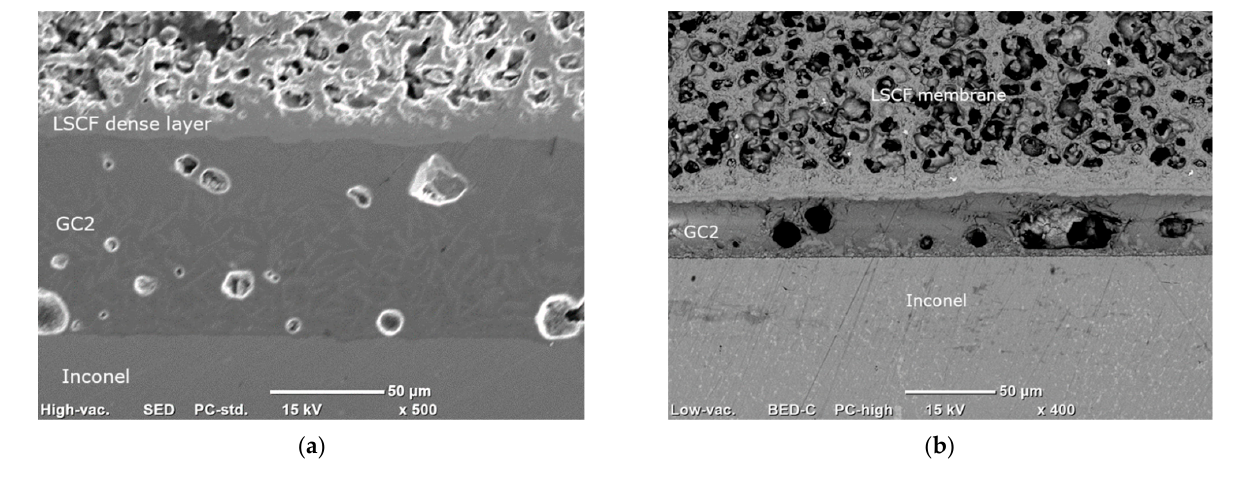
Figure 18. ( a ) SEM cross section of a typical LSCF/GC2 glass–ceramic/Inconel joint and ( b ) LSCF/GC2/Inconel joint after aging 8 h at 900 °C in air. The difference in GC2 thickness between the two samples is due to the manual deposition procedure.